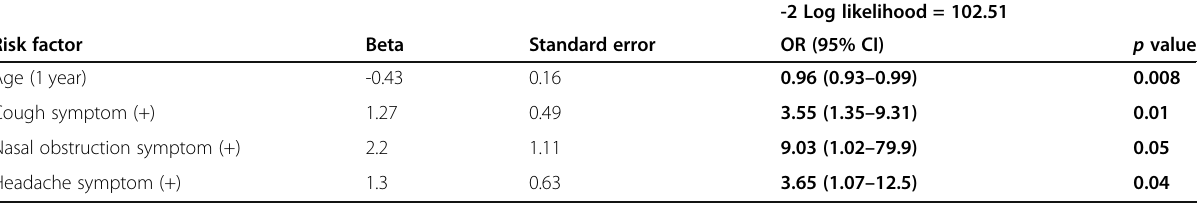
Table 2 The results of the logistic regression analysis evaluating the risk factors for the presence of taste and smell dysfunction